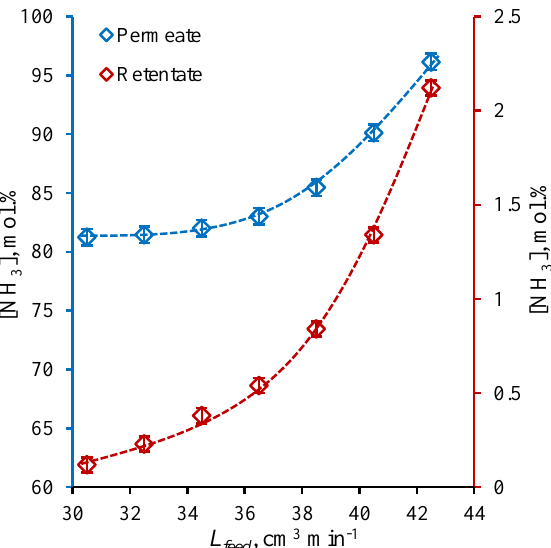
Figure 4. The NH 3 concentration (mol%) in permeate and retentate flows under a helium sweep of cell’s bore as a function of feed flow rate (cm 3 min − 1 ) during a steady-state ammonia capture process.